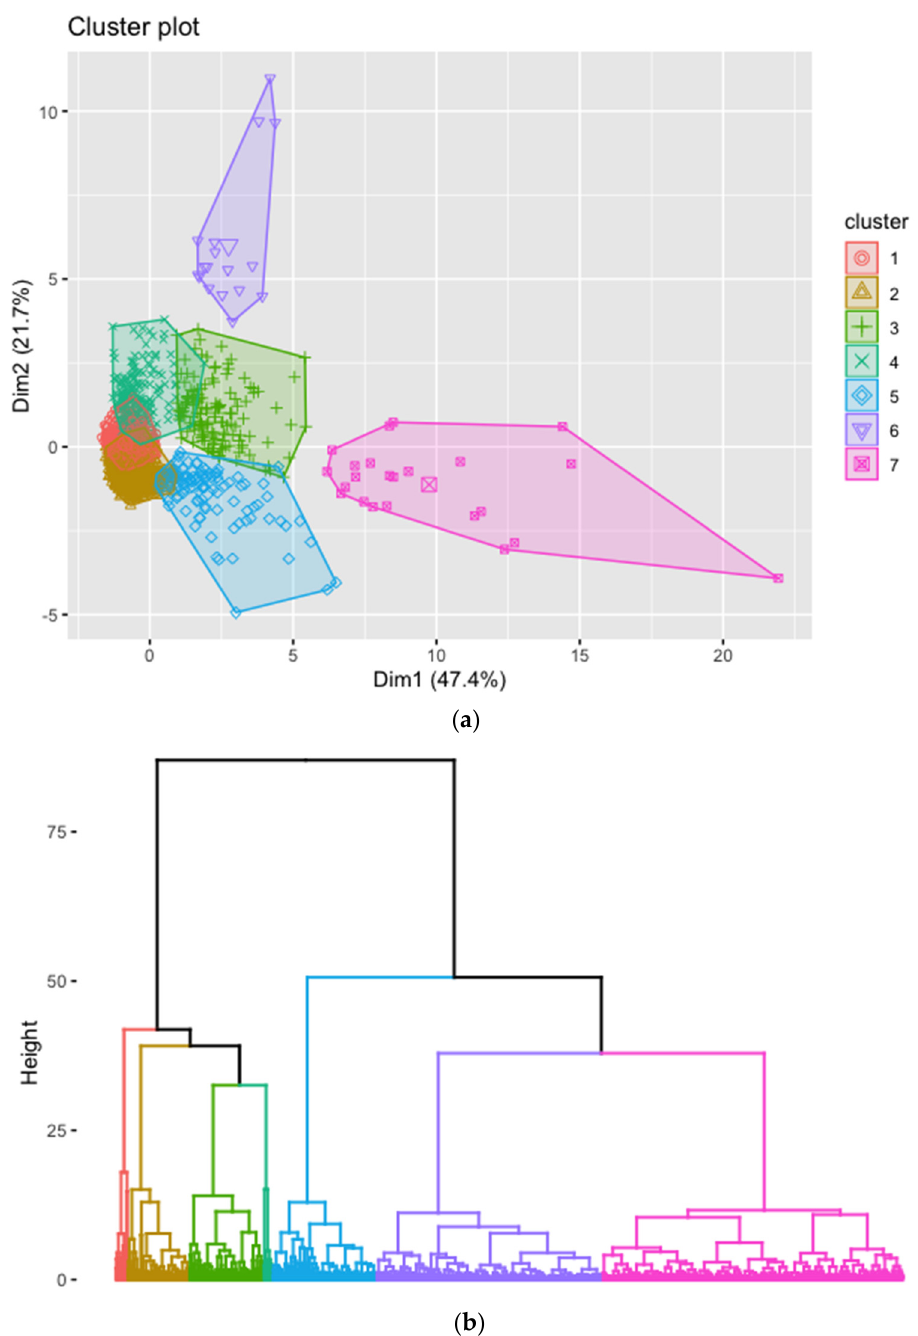
Figure 4. The first step of clustering in the space of the first two PCs ( a ) and as a dendrogram ( b ).